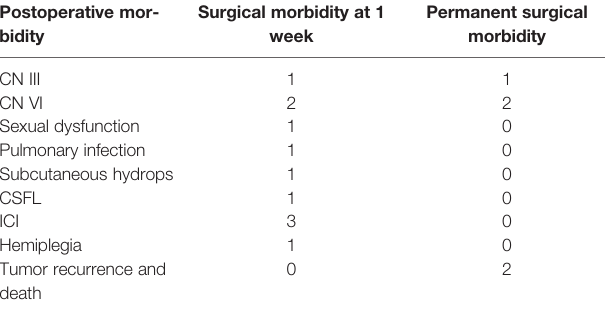
TABLE 3 | Surgical